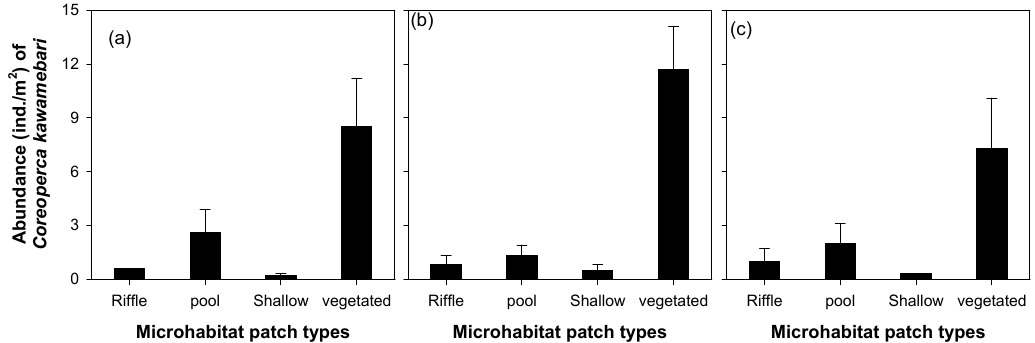
Figure 3. Abundance of Coreoperca kawamebari according to four microhabitat patch types in three study sites (from the left, sites 2, 4, and 8) located in the upper parts of the Geum River. Means labeled with a different letter indicate statistical subgroups defined by the post hoc test (Tukey honest significant difference (HSD), P = 0.05). ( a ) site 2, ( b ) site 4, and ( c ) site 8.